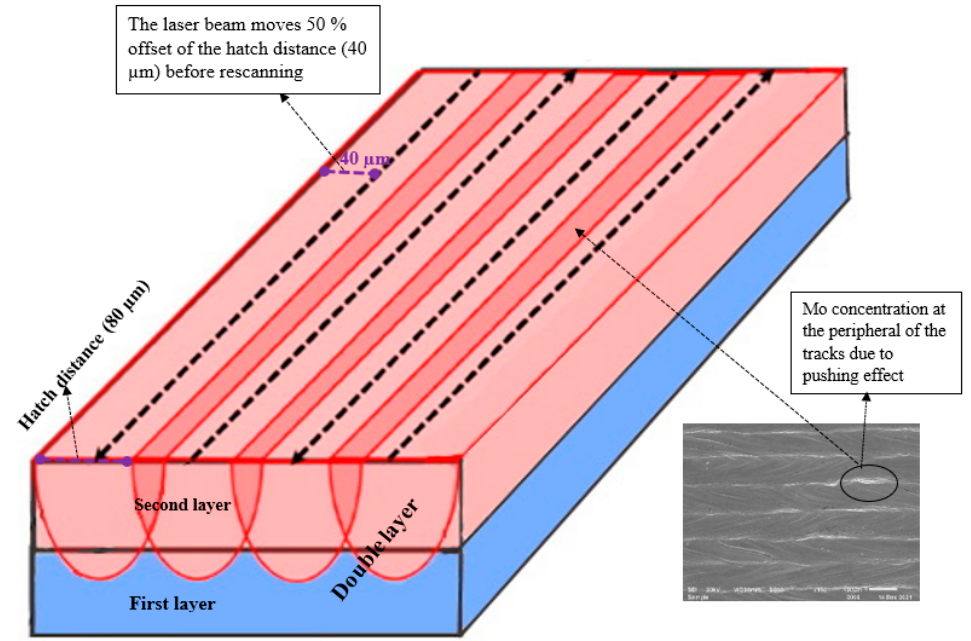
Figure 2. A schematic representation of the rescanning strategy.